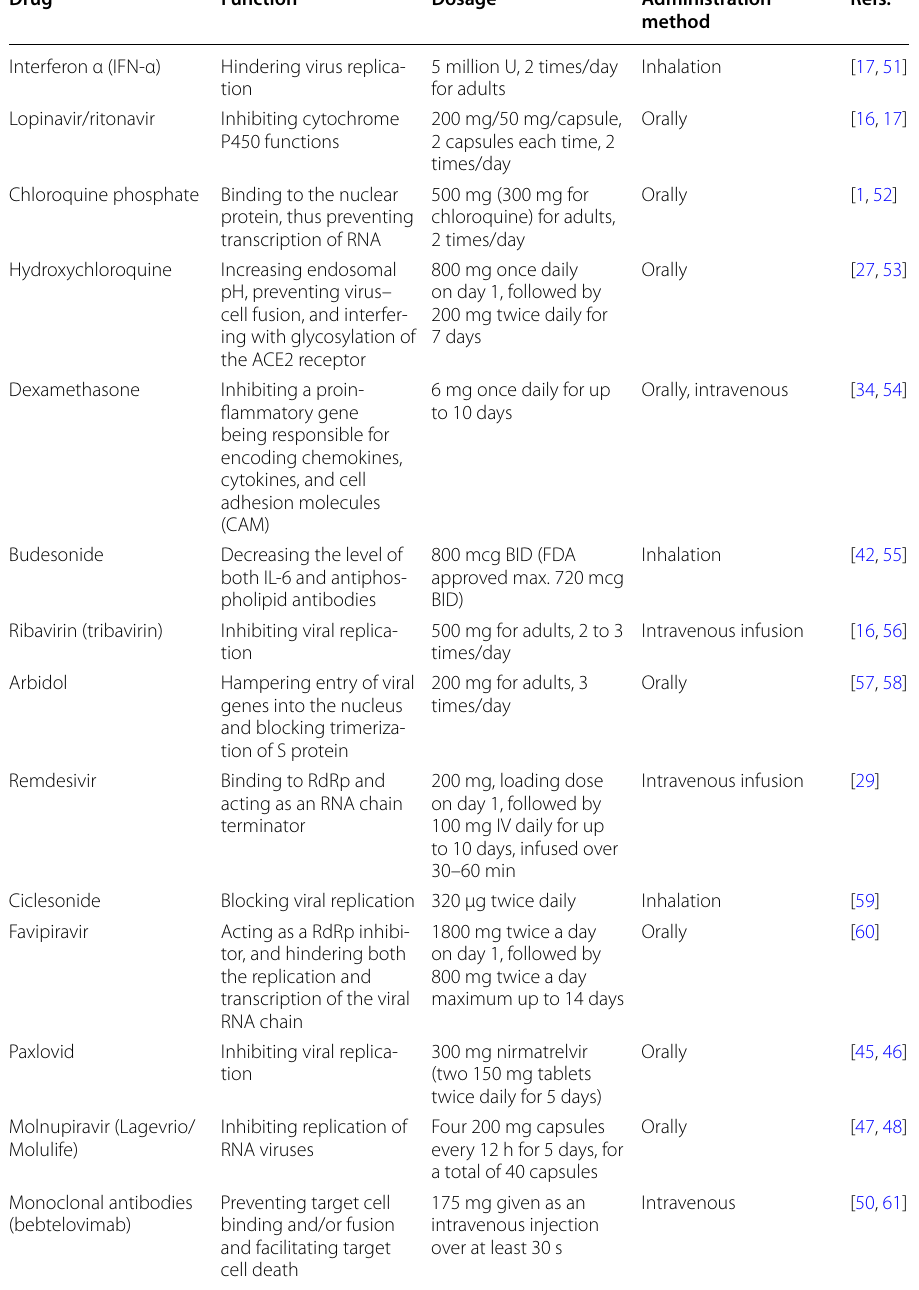
Table 1 Drugs used to treat COVID-19 and corresponding information Drug Function Dosage Administration Refs. method Interferon α (IFN-α) Hindering virus replica- 5 million U, 2 times/day Inhalation tion for adults Lopinavir/ritonavir Inhibiting cytochrome P450